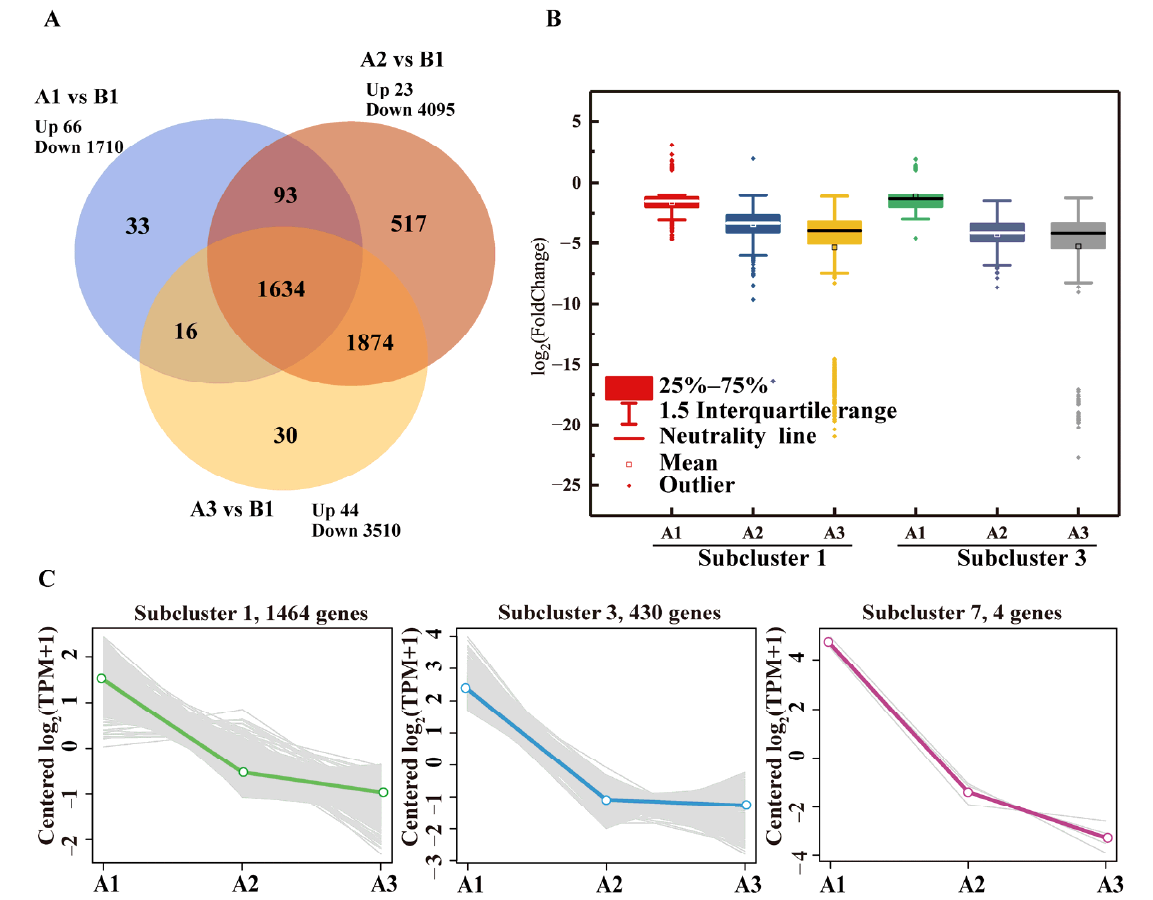
Figure 3. Analysis of differential gene expression in R-001 in response to BPA. ( A ) Venn diagram of gene expression patterns among samples treated with BPA. ( B ) Expression levels of DEGs in subclusters 1 and 3 across the different treatment groups. ( C ) Trends in gene expression patterns of the genes in the downregulated gene clusters.